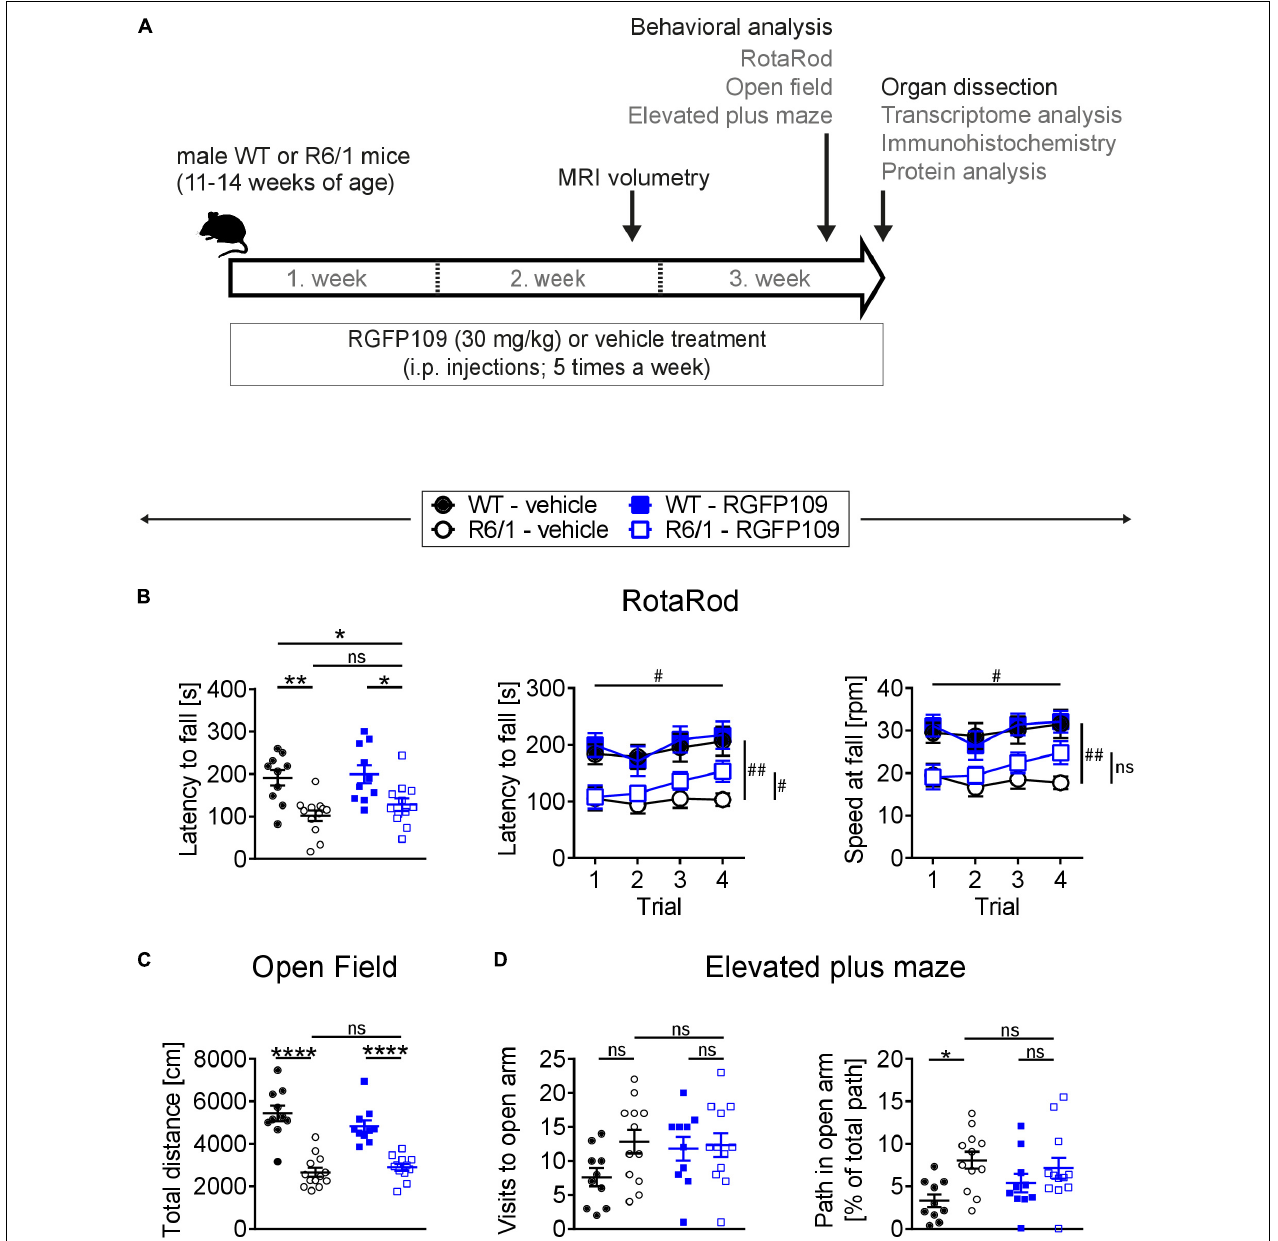
FIGURE 1 | RGFP109 treatment improves motor learning in R6/1 mice. (A) Schematic of treatment and experimental procedure. (B) Motor performance and learning on a RotaRod: Latency to fall as mean of all trials, latency to fall and speed at fall as learning curve over the course of four subsequent trials. (C) Open field exploration evaluating general locomotor activity measured as total distance traveled. (D) Anxiety-related behavior determined by elevated plus maze test showing visits to open arm and path traveled in open arm normalized to the total path. WT, wild type. Data presented as mean ± SEM; n = 10 [WT-vehicle], n = 12 (13,